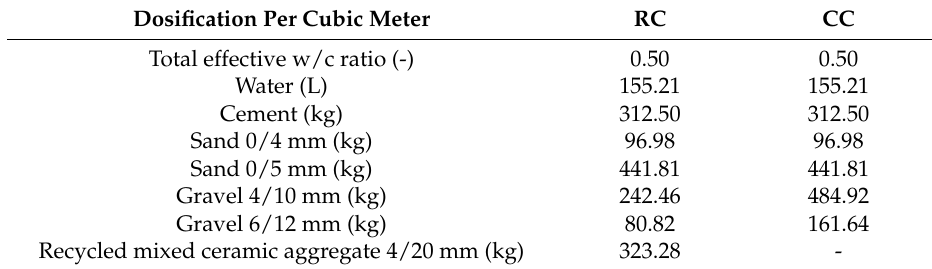
Table 3. Mix proportions per cubic metre of recycled concrete (RC) and control concrete